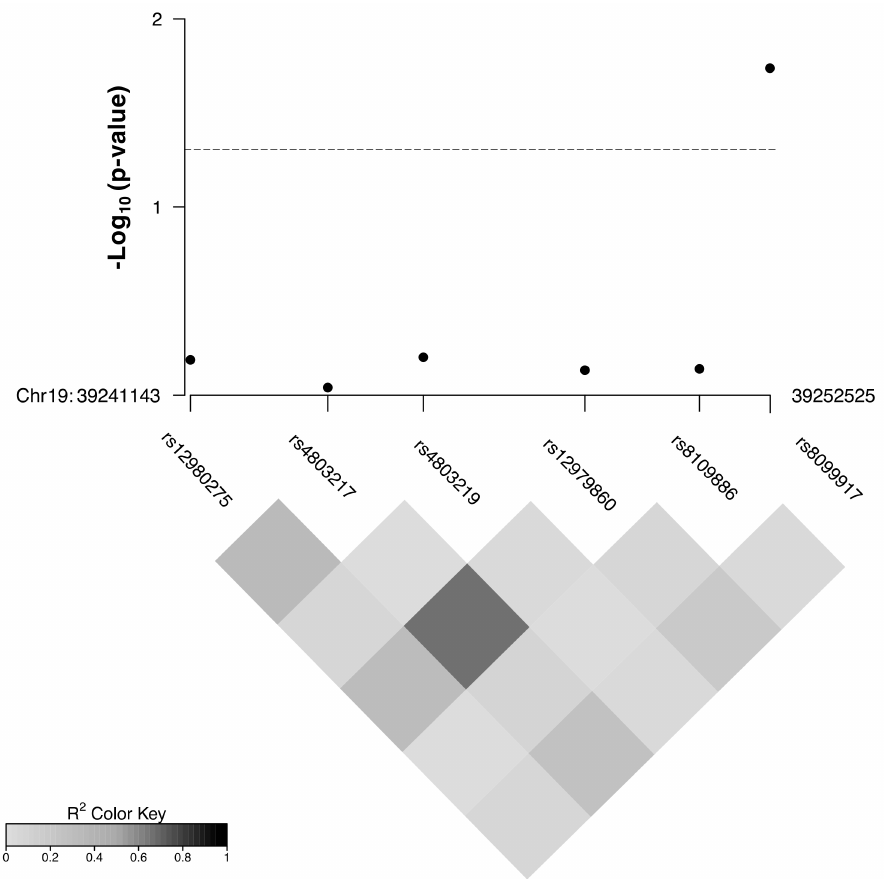
Figure 1. Linkage disequilibrium patterns and association between non-coding polymorphisms in Interferon- λ genes and congenital Zika syndrome in Campina Grande cohort. The p -values were obtained from log-additive logistic regression models adjusted for genetic ancestry and trimester of infection during pregnancy (first trimester or other). Dashed line stands for p -value =